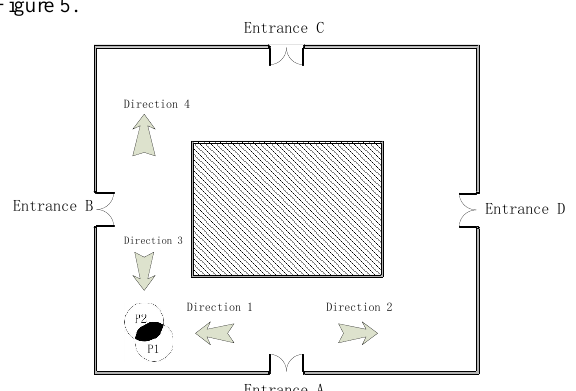
Figure 5. Probabilistic constraints for multi - target positioning According to the network structure, the entrance and corners are selected as the key nodes, and the distance of each node is known. Take initial position of entrance of the building as the first node, the distance is recorded according to the principle PDR method. The condition is that A, B are two entrances and it has more than one subject. There is no doubt that person P 1 heads to the direction 1 and P 2 heads to the direction 3. The forward direction is 1,2,3,4.